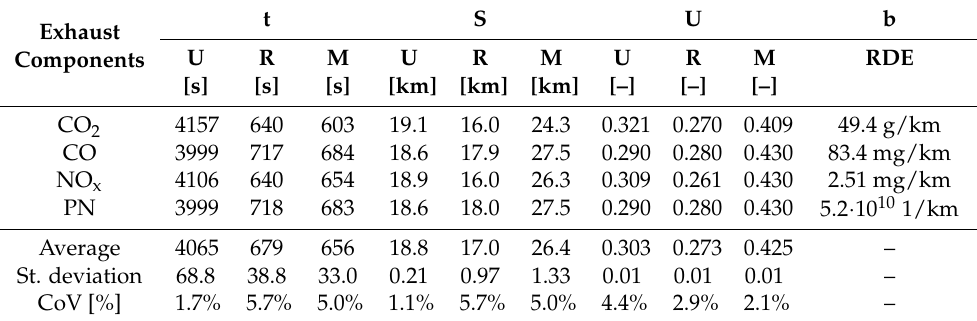
Table A2. Road emissions for the RDE test (assuming constant exhaust emission intensity)—output data obtained from the algorithm and the proposed values for the generalized test (Vehicle A).